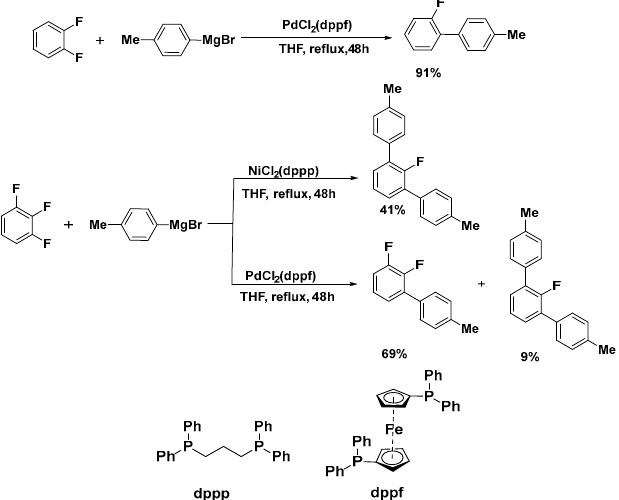
Scheme 10. Cross–coupling of fluoro–aromatic with Grignard reagents.